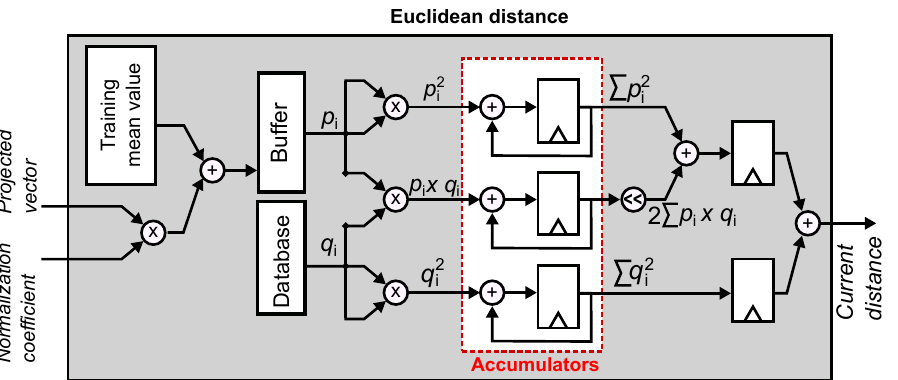
Figure 12. Euclidean distance module. It normalizes and centers the input vector and computes the distance between vectors p and q as ∑ p 2